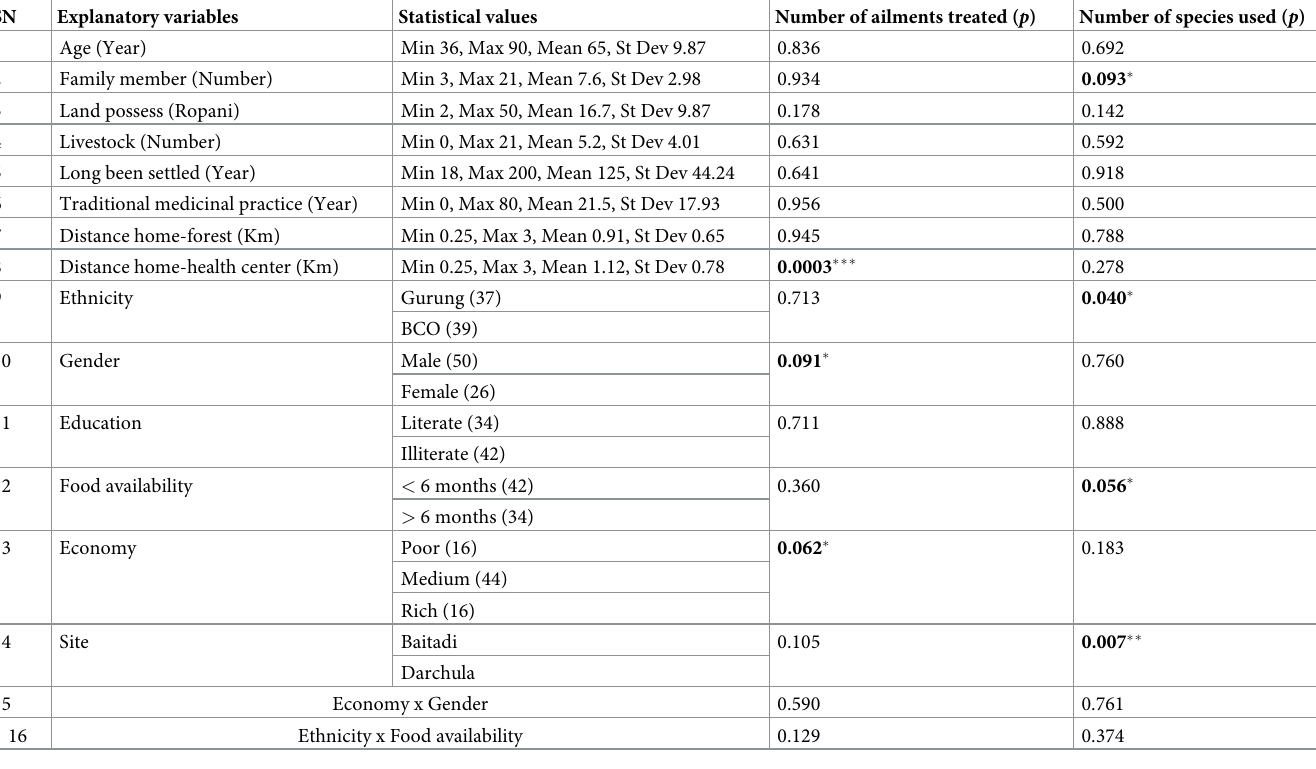
Table 3. Correlation coefficients of the variables